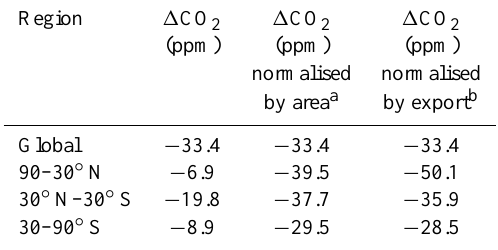
Table 2. Changes in atmospheric CO 2 induced by a global/regional deepening of the depth scale ( l POM ) from 250m (control) to 275m in the open system. Negative numbers denote a decrease in CO 2 .